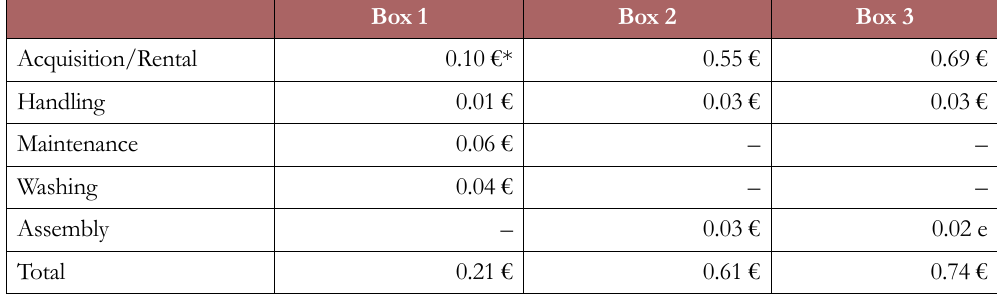
Table 2. Process costs for each type of box